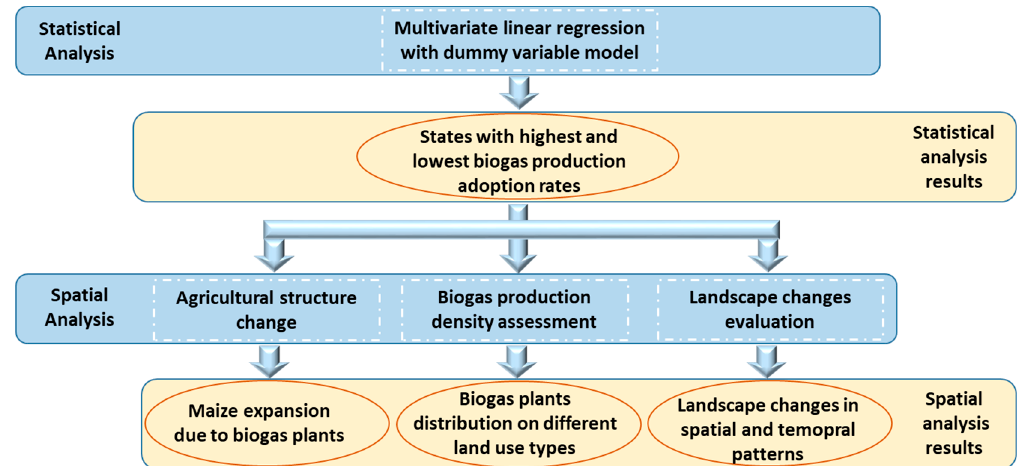
Figure 1. The overview of the current research framework.